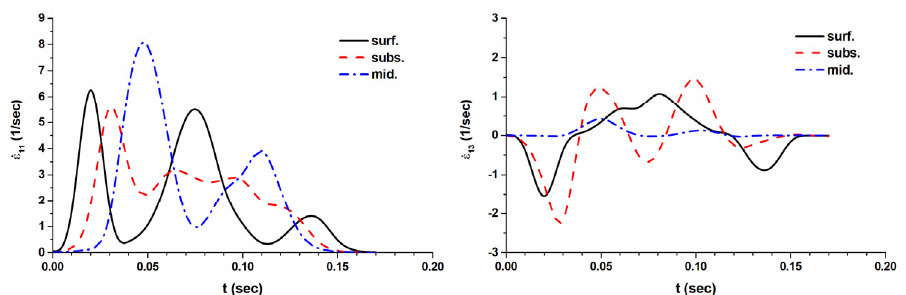
Figure 16. Strain rates in symmetrically rolled sheet, calculated by FEM for different thickness layers: surf.—is a surface layer; subsurf. layer is equidistant from both surface and middle; and mid. is the midthickness layer.